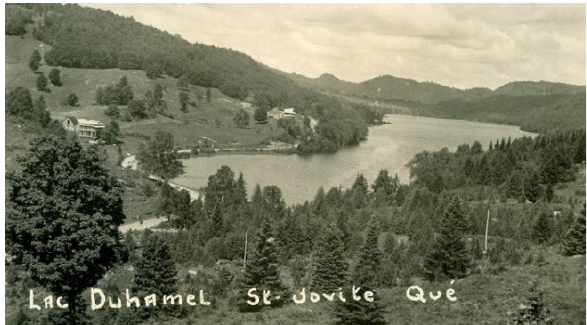
Figure 3. Lac Duhamel, Mont-Tremblant, Quebec